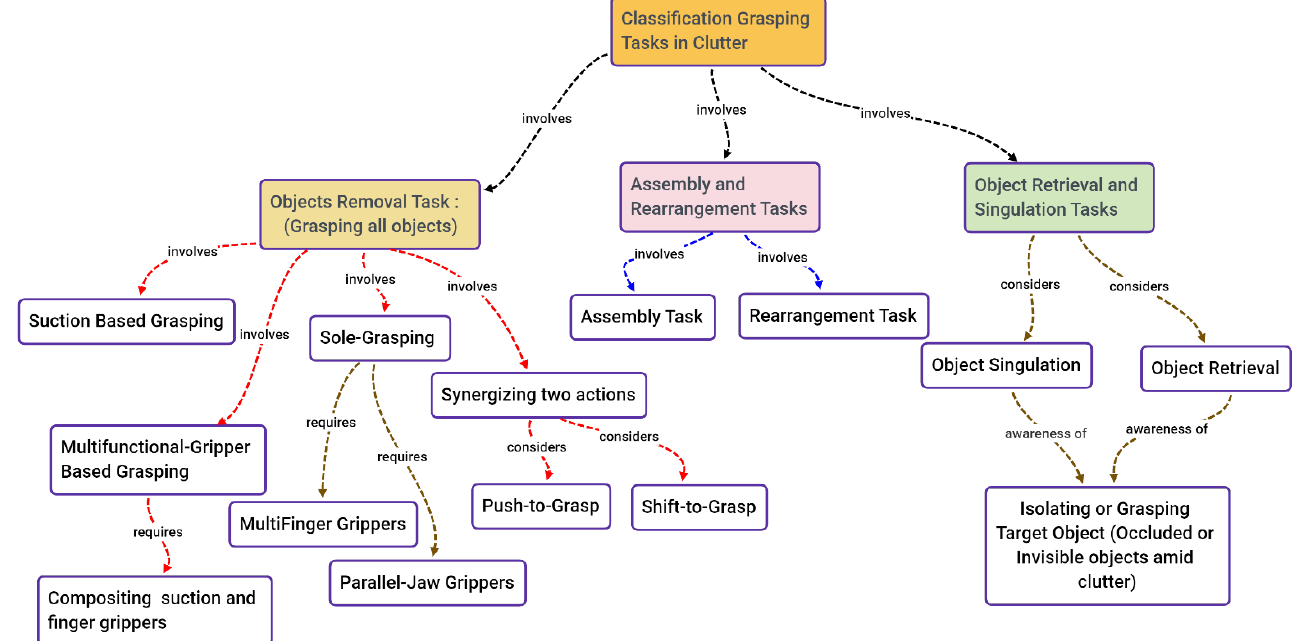
Figure 3. Taxonomy of the final set of articles.